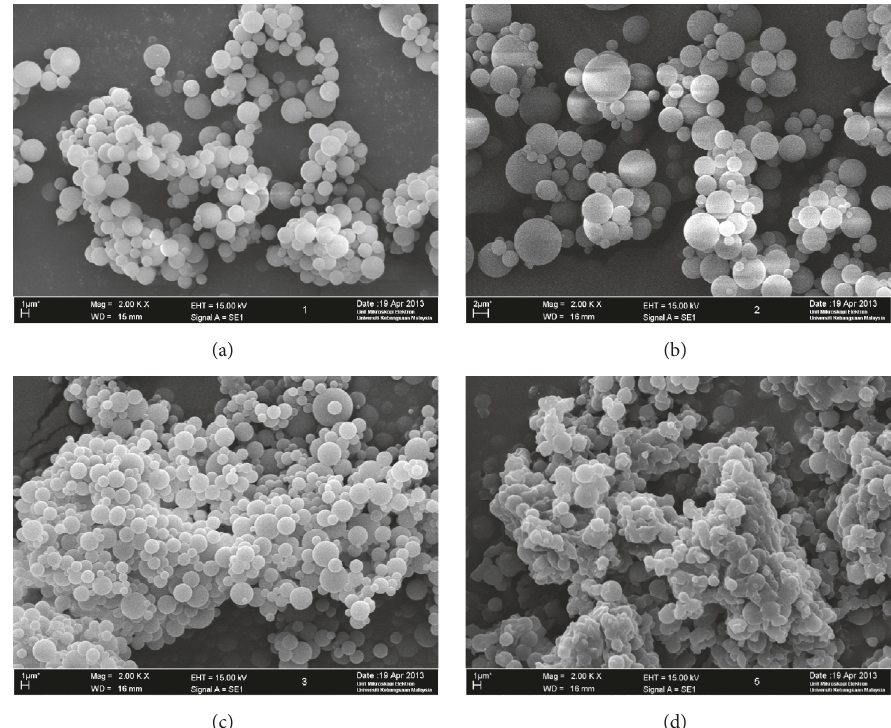
Figure 3: SEM micrographs of polyGMA (a), poly n BA (b), GN91 copolymer (c), and GN82 copolymer (d) at 2.00 Kx magnification and size distribution of poly(GMA- co - n BA) microspheres in various compositions.